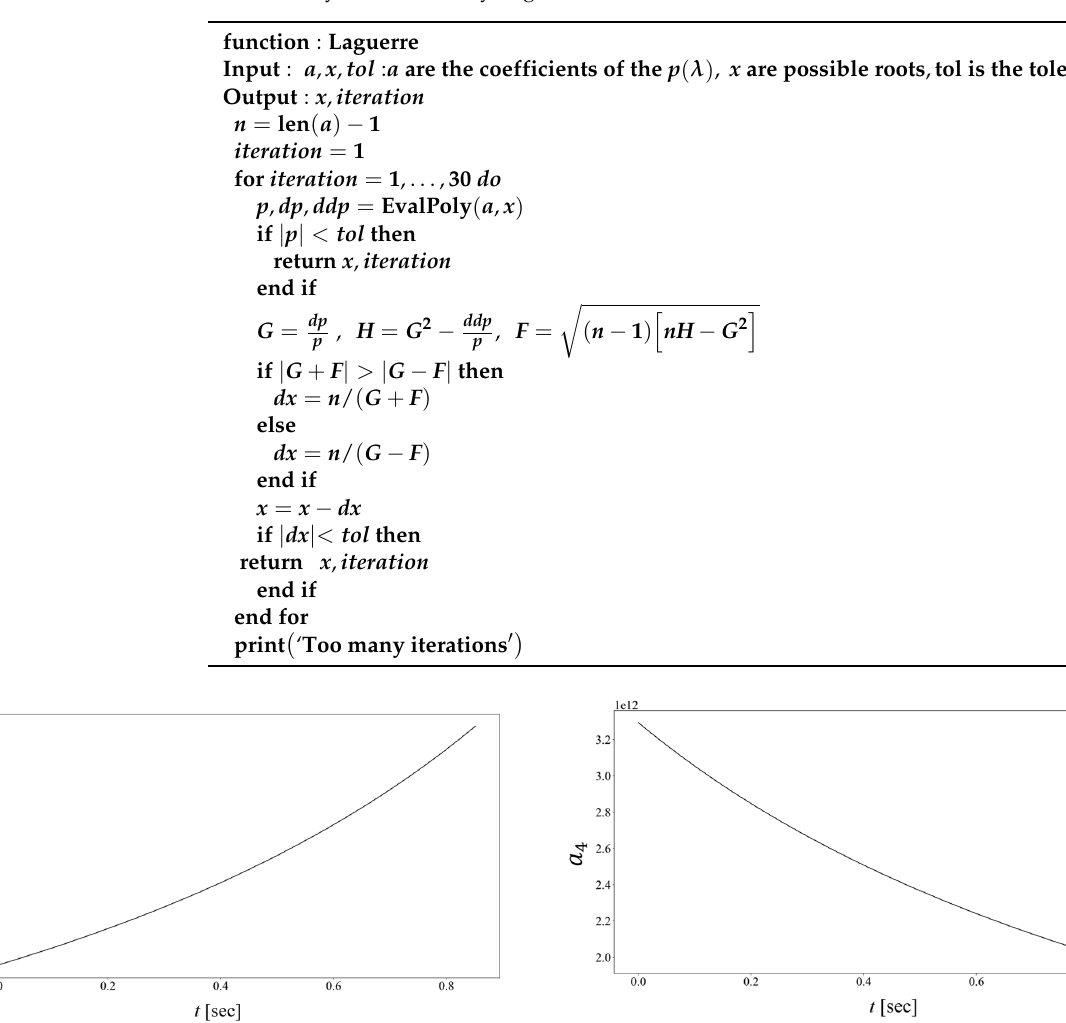
Table 5. Polynomial roots by Laguerre’s method.